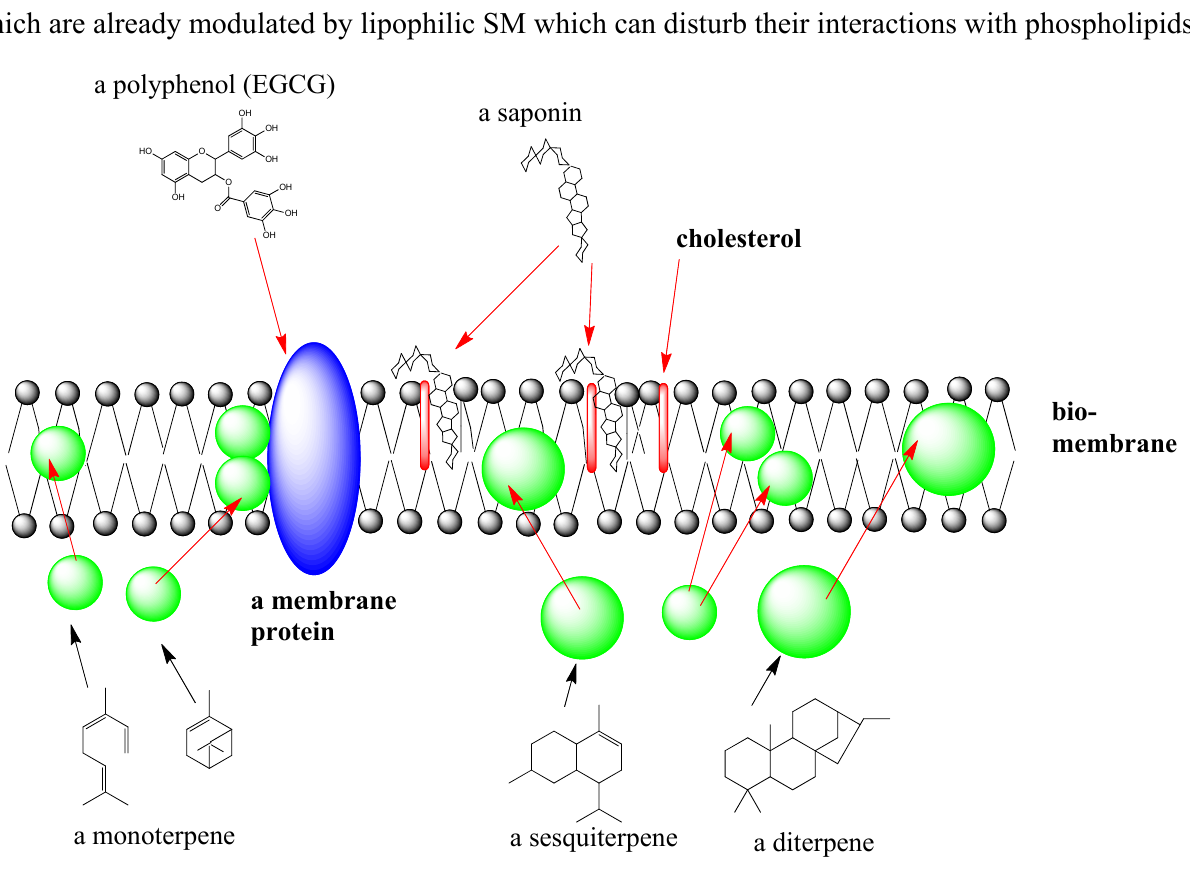
Figure 3. Interaction of SM with biomembranes. Saponins can complex membrane cholesterol; polyphenols influence 3D structure of membrane proteins (receptors, transporters, ion channels); small lipophilic terpenoids assemble in the inner lipophilic core of the biomembrane (after